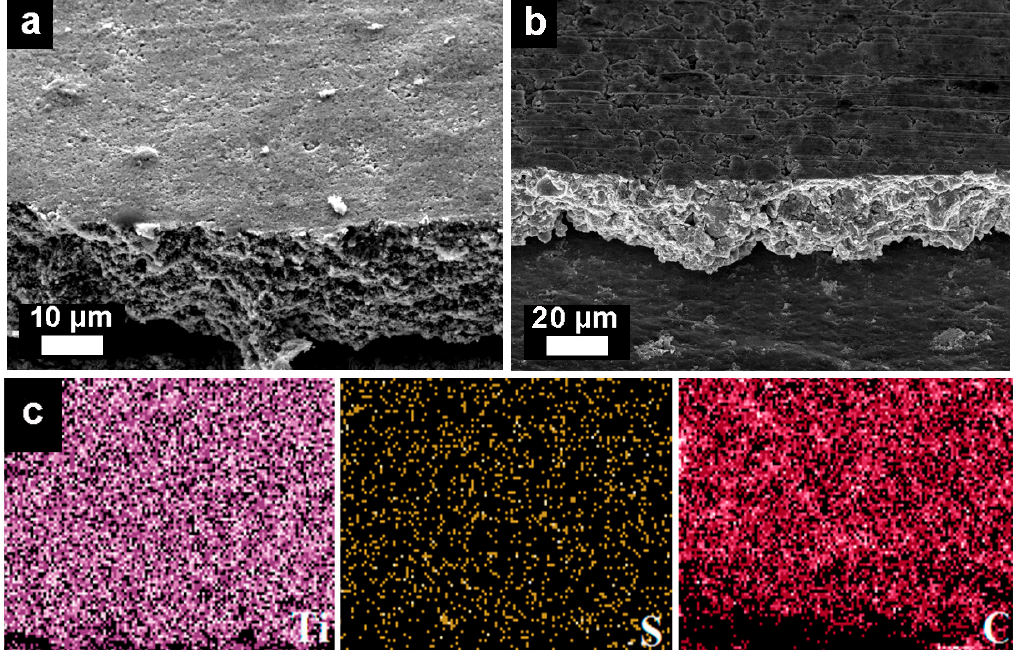
Figure 2. Sectional SEM images of freshly prepared electrode layers on Al current collector: ( a ) LTO PEDOT:PSS/CMC ; ( b ) LFMP PEDOT:PSS/CMC ; and ( c ) EDX element mapping of LTO PEDOT:PSS/CMC electrode (our data from Ref. [64,65]).